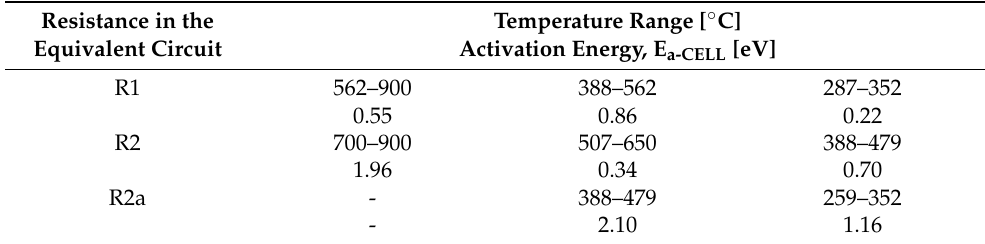
Table 4. Activation energy values for the resistance components of Pr005|LSGM|Pr005 cell.